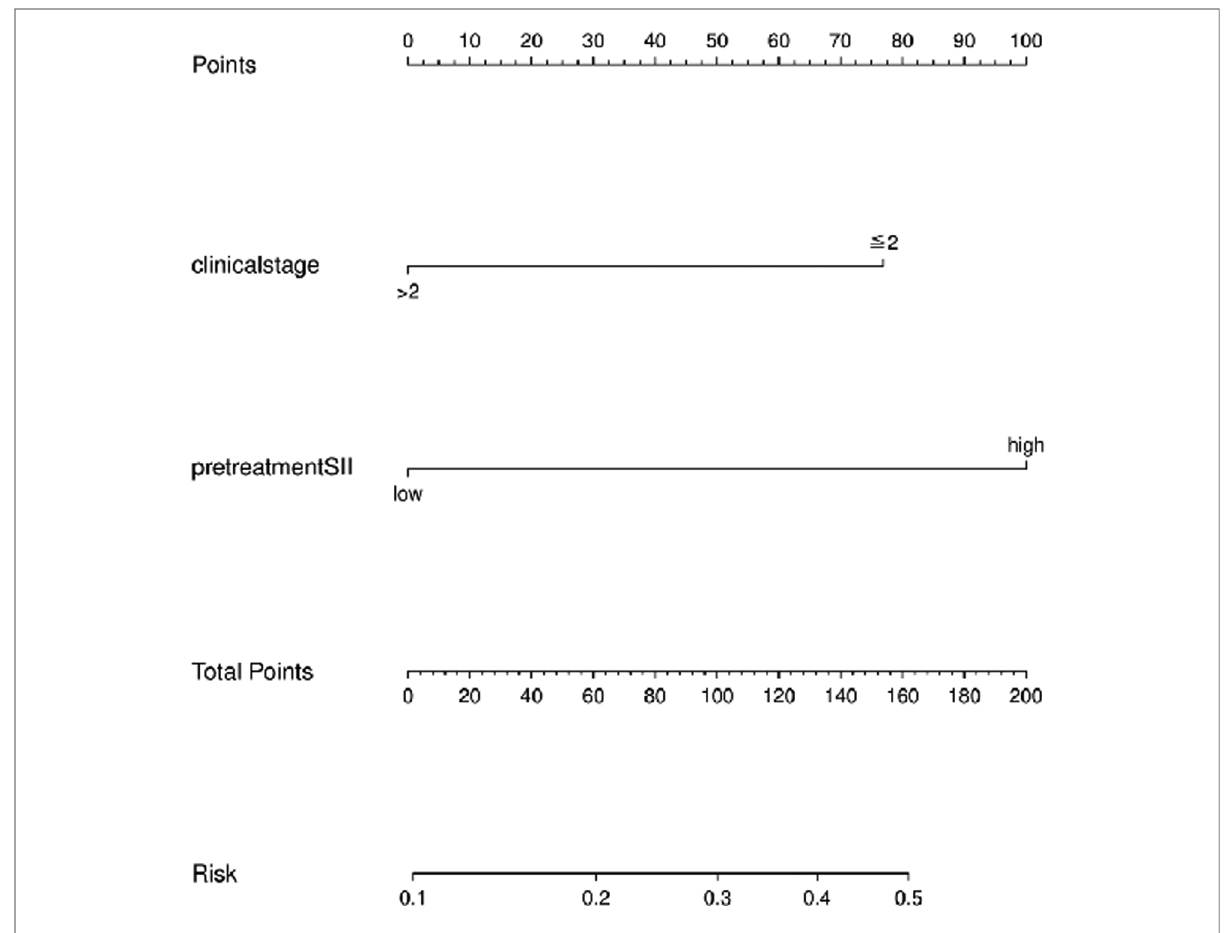
FIGURE 3 Nomogram model to predict pCR among ESCC patients receiving nICT.